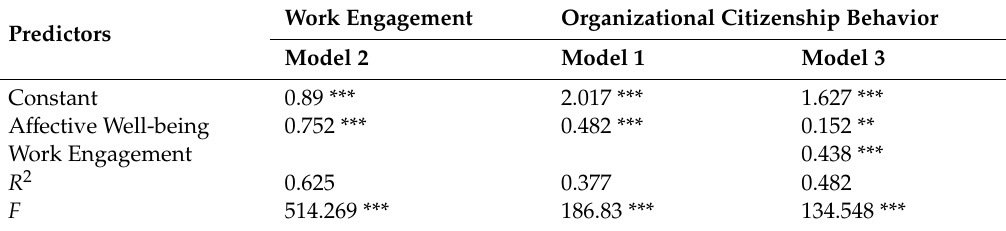
Table 3. Mediation e ff ects of work